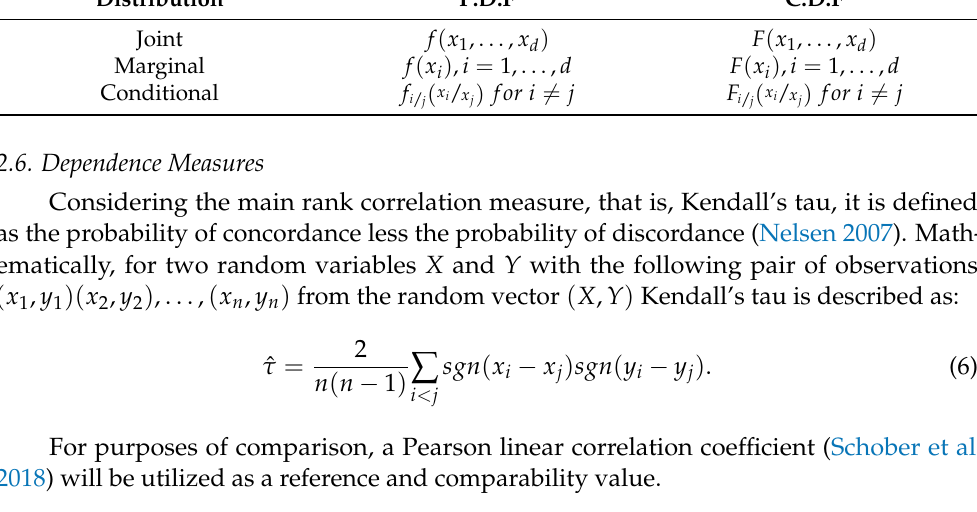
Table 2. P.D.F and C.D.F of the joint, marginal, and conditional distribution. Distribution